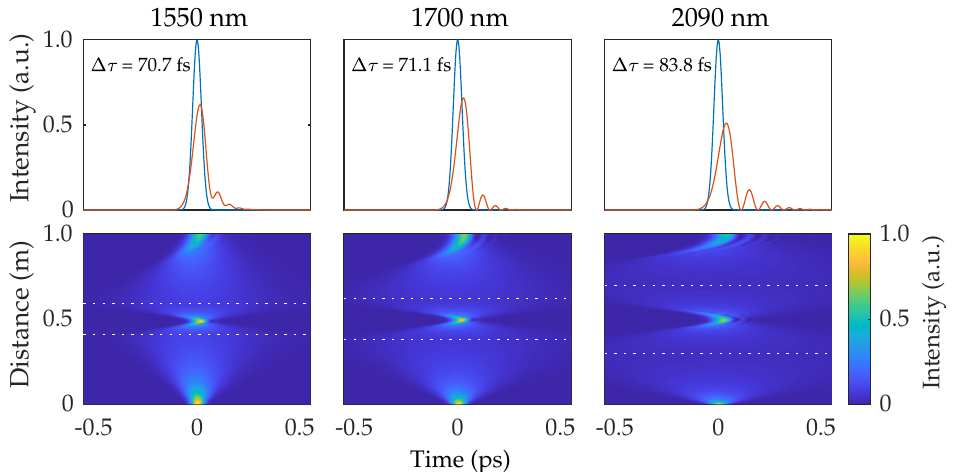
Figure 4. Top row: pulse temporal intensity before (blue) and after (red) propagation through SMF-28 and UHNA3. Bottom row: evolution of the temporal intensity profile through the system of cascaded fibers. White lines indicate transitions between different fibers.